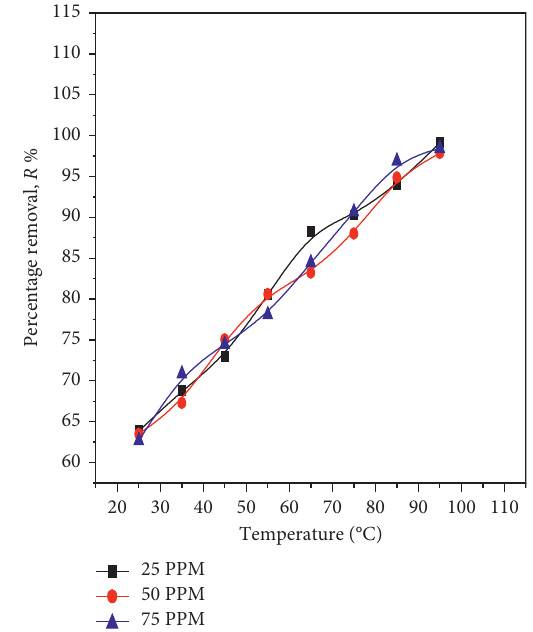
Figure 13: Effect of temperature on the adsorption of dye onto AC.